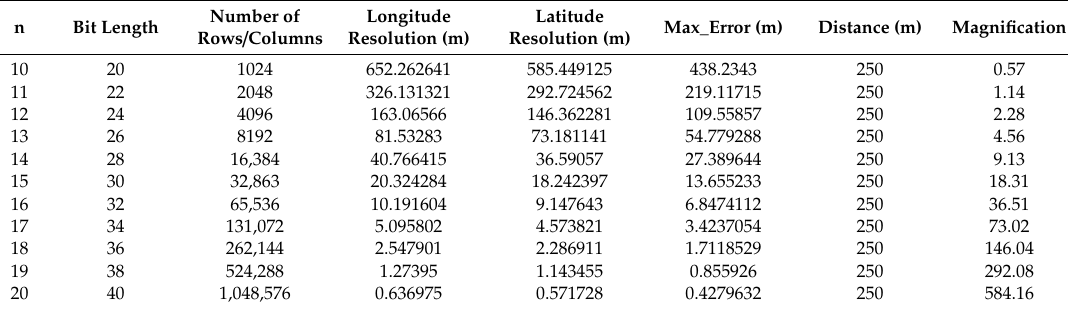
Table 4. Result of precision